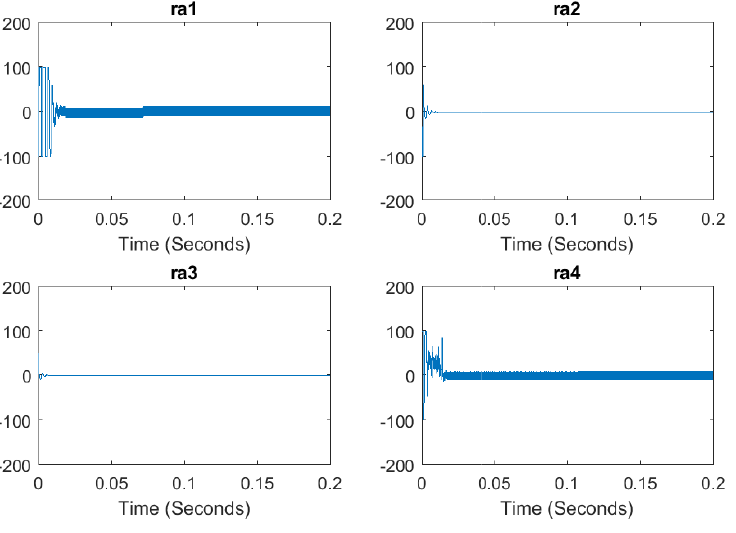
Figure 16. Simulation of residuals in the case of a healthy